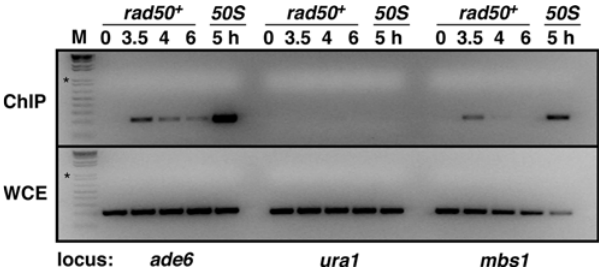
Figure 2. Rec12-DNA Covalent Linkages Are Readily Detectable in rad50 + Strains. Chromatin was prepared from meiotically induced rad50 + (GP6232) and rad50S (GP6203) strains bearing FLAG-tagged Rec12 and immunoprecipitated with anti-FLAG antibody. Enrichment for Rec12-linked DNA was assayed by PCR at two DSB hotspots ( ade6- 3049 and mbs1 ) and one coldspot ( ura1 ); template for the PCR was immunoprecipitate (ChIP) or whole cell extract (WCE). The maximal PCR signal was at 3.5 h in the rad50 + strain, in agreement with the time of maximal DSBs (Figure 1). In addition, there is little or no signal before meiotic induction (0 h); the signal decreases as meiosis progresses, indicating the initial step of DSB repair. The 5 h rad50S DNA shows a much stronger enrichment (ratio of PCR product from the ChIP to that from the WCE) as a result of Rec12 not being removed from the DNA ends in that strain. Neither strain showed any meiotic enrichment of Rec12-DNA linkages in the DSB coldspot in ura1 . On the left are size markers (1 Kb Plus DNA Ladder; Invitrogen); asterisk, 1